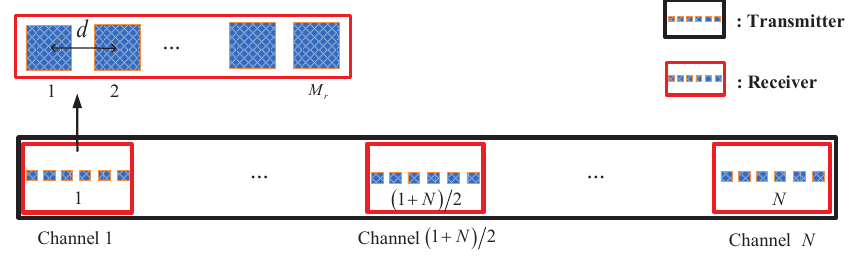
Figure 5. Diagram of transmitter and receivers.